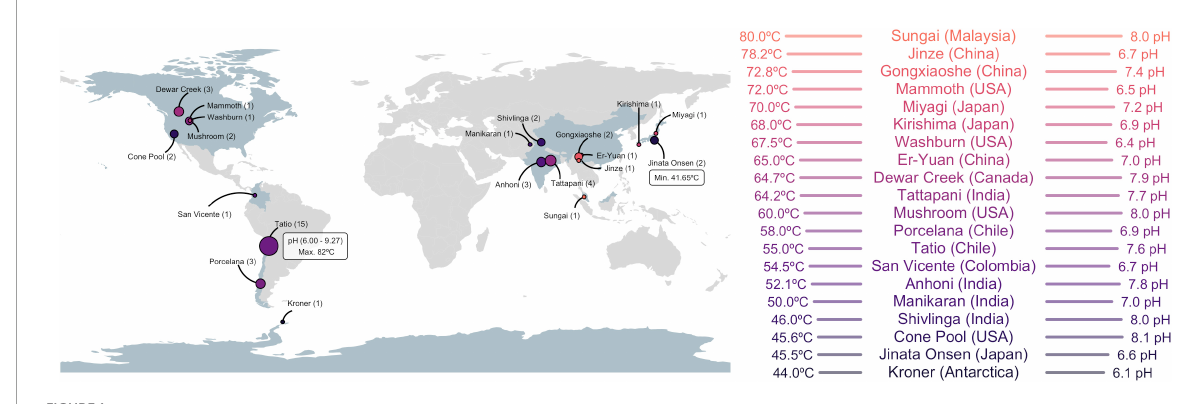
FIGURE1 Geographic locations of hot springs used in this study (left) , with the number of metagenomic data sets in parenthesis (proportional to circle size). The temperature and pH limits of the survey (white box) and the average temperature and pH of each hot spring site (right) are indicated. Detailed metadata of each sample are provided in Supplementary Table 1